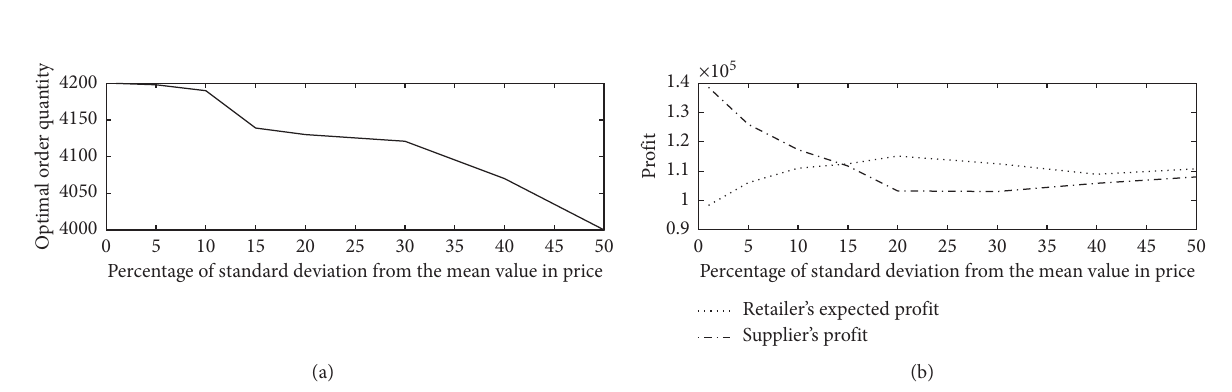
Figure 3: The impact of price fluctuation on the optimal order quantity.